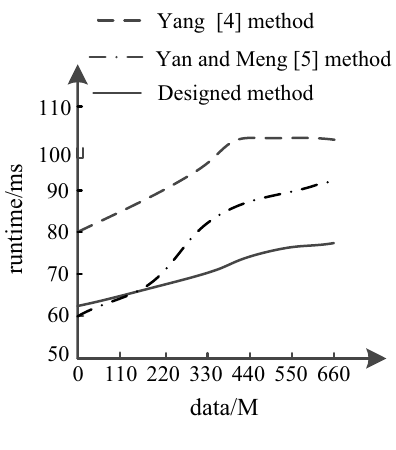
Figure 5: Comparison of